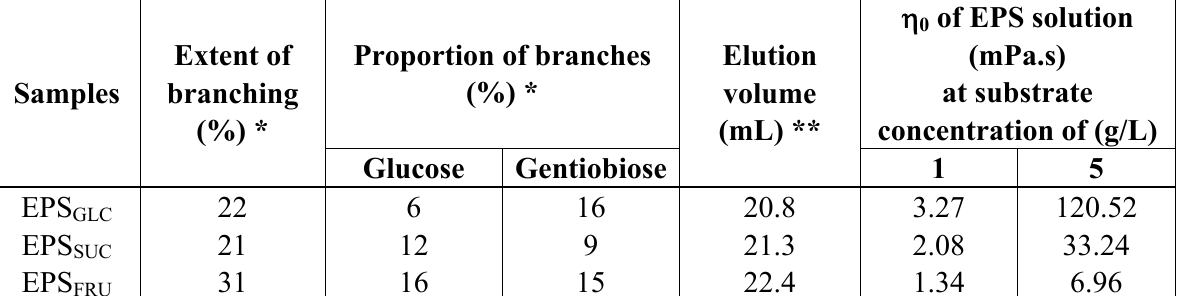
Table 2. The degree of branching, proportion of glucose and gentiobiose branch units, elution volume, and  of the three 0